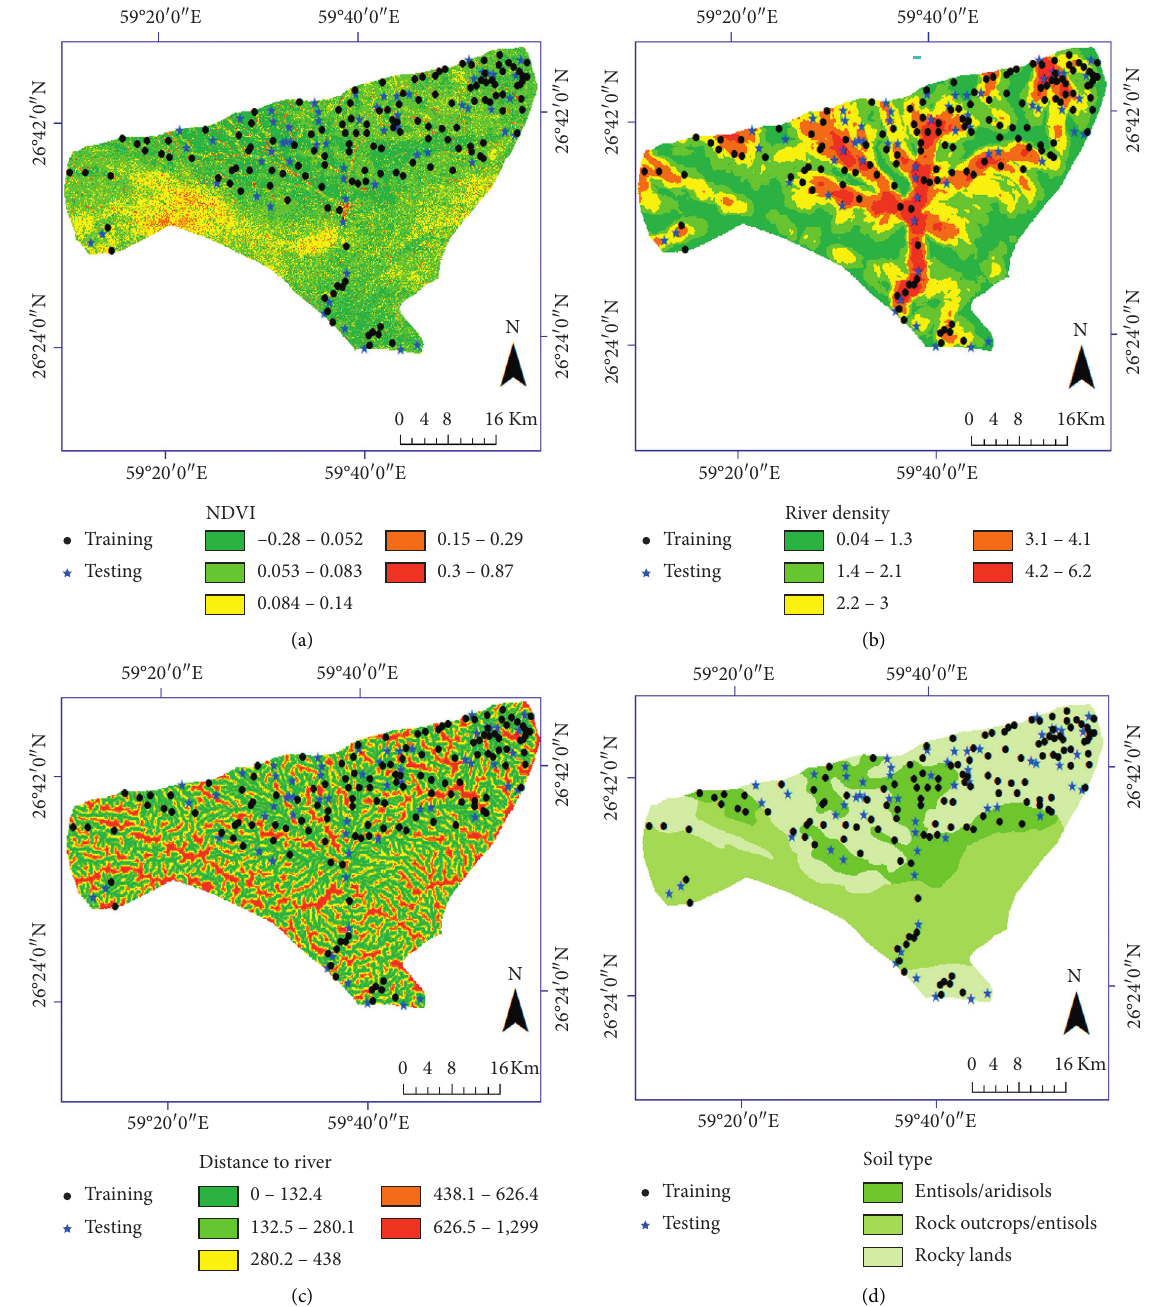
Figure 6: (a) NDVI. (b) River density. (c) Distance to river. (d) Soil